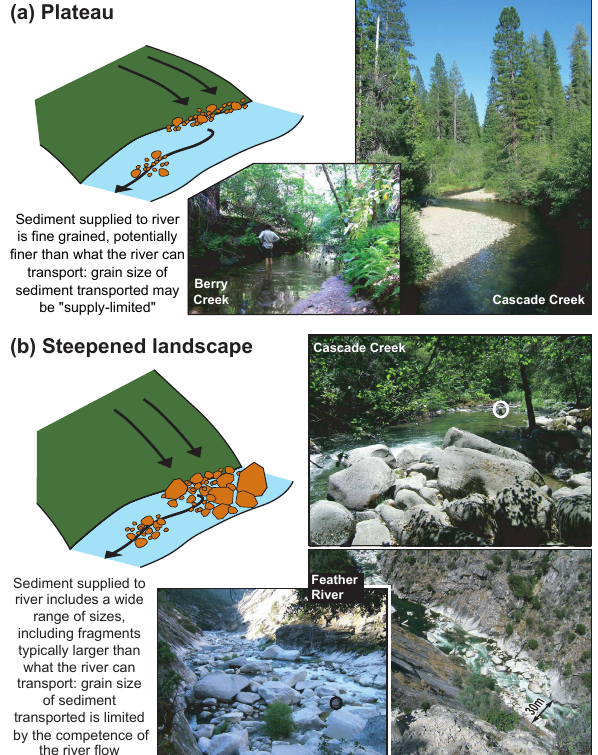
Figure 11. Diagrams and photographs illustrating the contrast in sediment dynamics between sites on the plateau and sites across the steepened landscape. (a) On the plateau, rivers are fed with soil material and there is a clear lack of coarse material, even along large rivers; the drainage area of Cascade Creek where the photo was taken is 58km 2 and the largest pebble found in the area has a b axis of 260mm. (b) Along the steepened reaches of the rivers and in the gorges, a wide range of grain size is available and “lag” deposits are widespread, that is, concentrations of very large clasts resulting from the reworking by fluvial processes of material deposited by mass wasting processes. The very large boulders are up to 10m in size and are very unlikely to be mobilised by fluvial processes. Photographs show evidence of reworking of debris-flow deposits near the confluence of Cascade Creek with the Feather River (top panels), selective mobilisation of sediment supplied by landslides, and rock falls below Bald Rock Dome in the Feather River (bottom panels). Standing people are circled on the photographs for